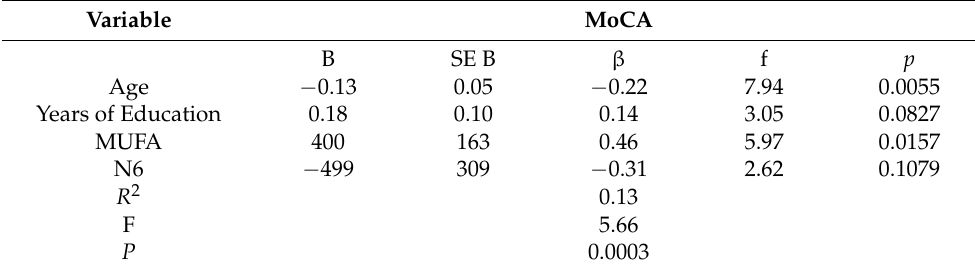
Table 3. Association between MoCA score and consumption of monounsaturated fatty acid (MUFA). Variable